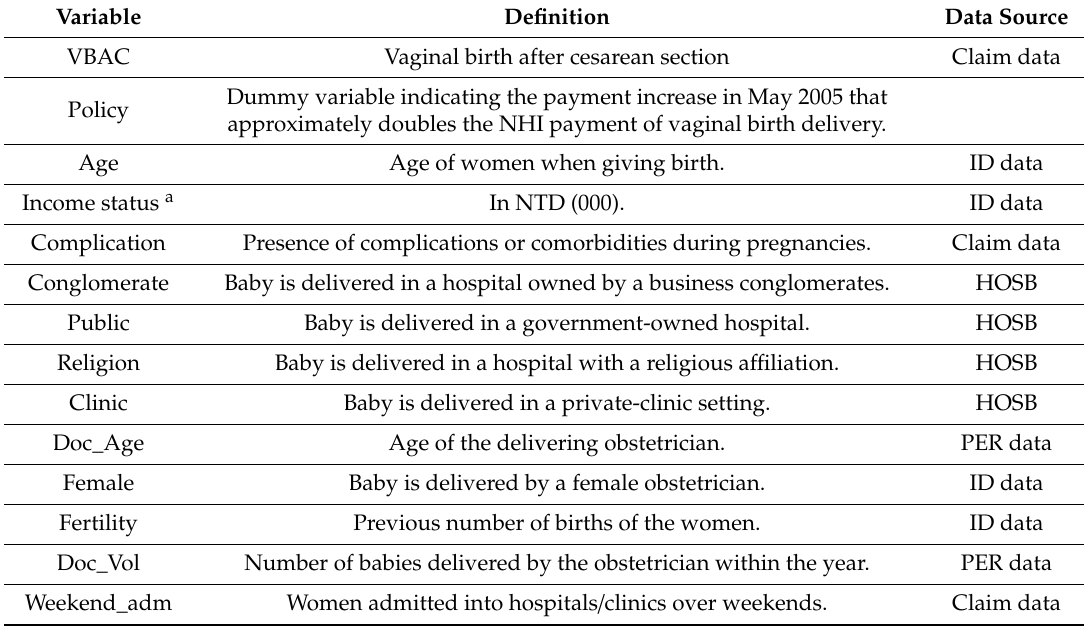
Table 1. Definition of Variables and Data